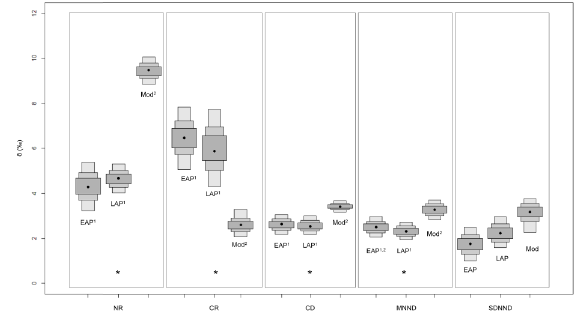
Figure 4. Probability values of Layman’s metrics over the time in the southern Patagonia. Metrics that present differences over the time are indicated by an asterisk ad superscripts. Groups sharing the same superscript number (1, 2) are not significantly different. EAP=early aboriginal period; LAP=late aboriginal period; Mod=mo- dern